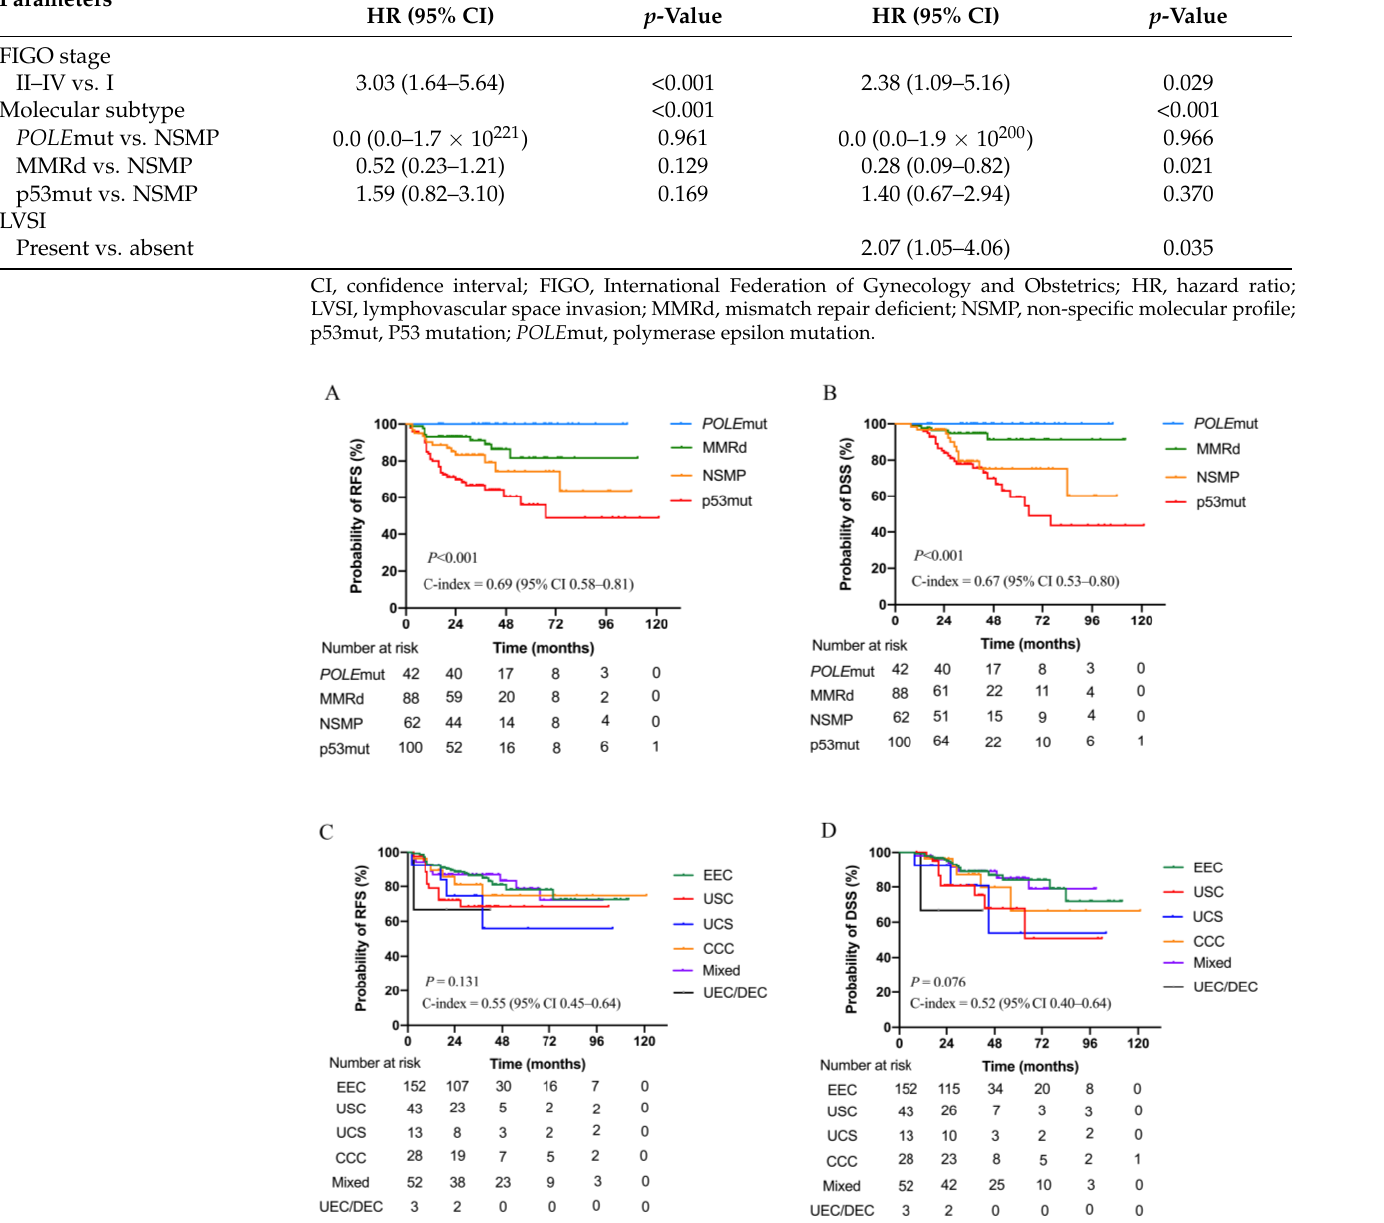
Figure 1. Kaplan-Meier curves showing the relapse-free survival (RFS) and disease-specific survival (DSS) of patients with high-grade endometrial carcinomas classified according to molecular subtype or histotype. ( A ) RFS stratified by molecular subtype; ( B ) DSS stratified by molecular subtype; ( C ),